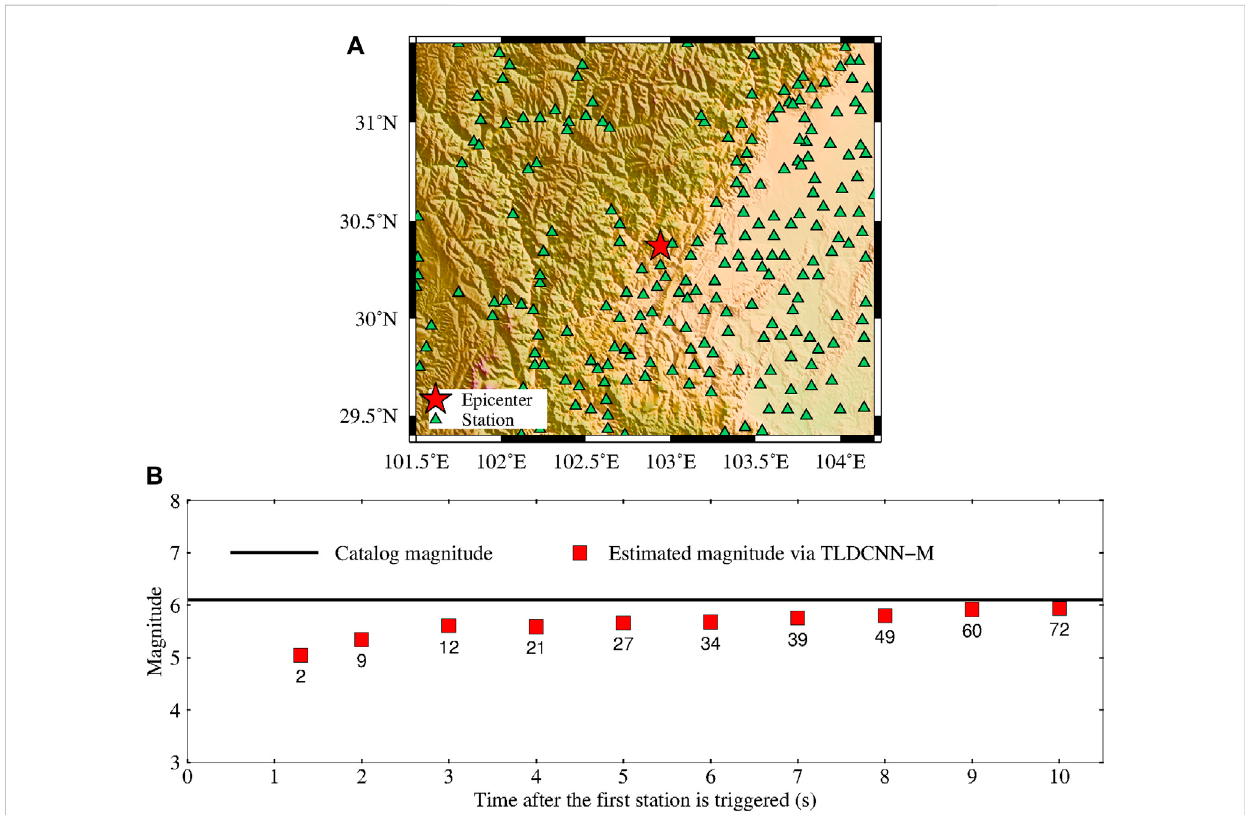
FIGURE 6 (A) The epicenter anddistribution ofstationsforthe2022LushanM6.1 earthquake. (B) Evolution ofthemagnitude estimationwiththetimeafter the fi rst triggered station. The black line represents the catalog magnitude, each red square represents the estimated magnitude via the TLDCNN-M model, and the number near the red square represents the number of triggered